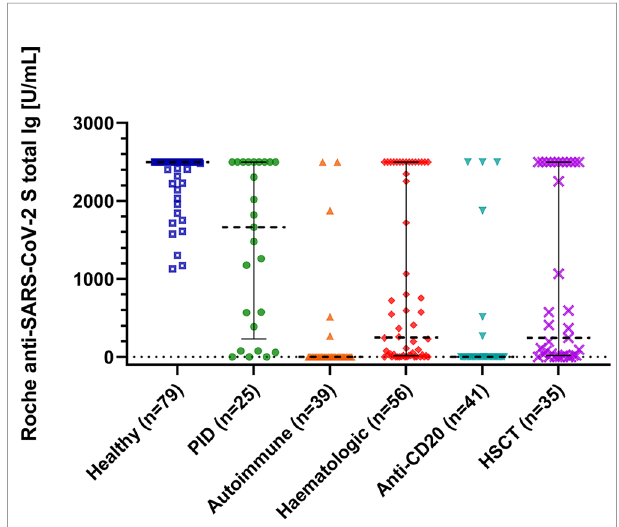
FIGURE 1 | Immune response to SARS-CoV-2 mRNA vaccination. The scatter plot shows total immunoglobulin levels for healthy controls, immunode fi cient patients and patients after anti-CD20 therapy or hematopoietic stem cell transplantation (HSCT). P is <0.001 between all groups calculated with the Kruskal-Wallis test and post hoc analysis. Lines are medians with interquartile range. The Plot was drawn with GraphPad Prism Version 9.2.0.332.